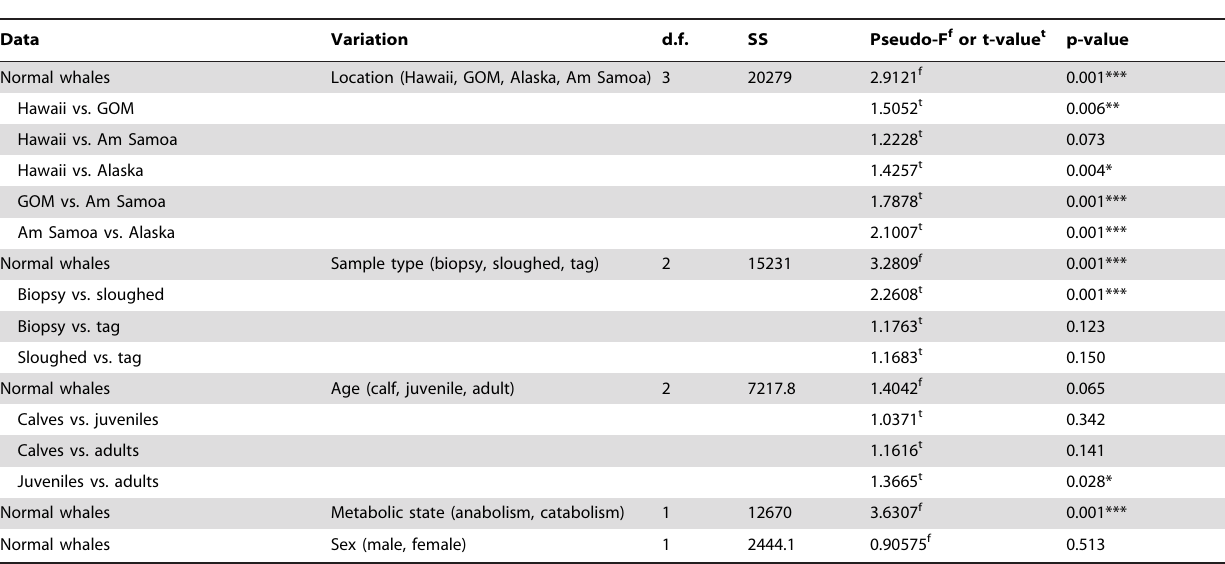
Table 2. PERMANOVA analysis of the effect of geographic area, metabolic state, age class, sex and sample type on the 97% OTU grouped bacterial SSU rDNA data from humpback skin (GOM =Gulf of